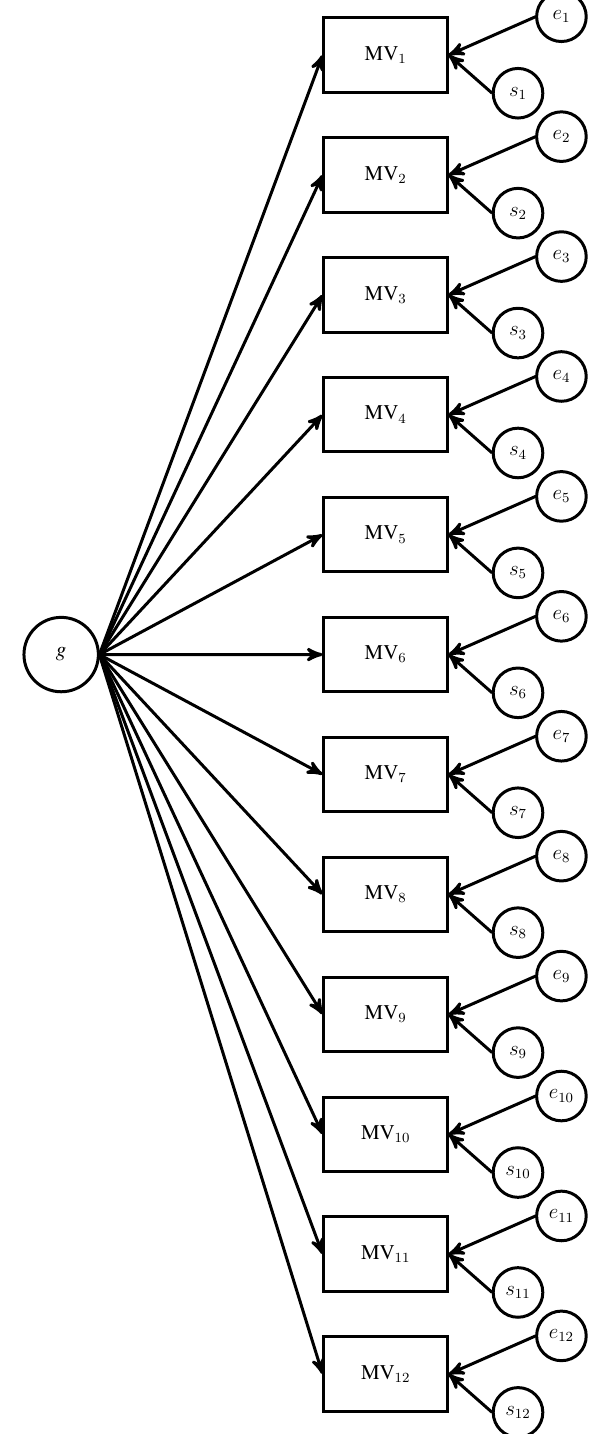
Figure 1. Example of a two-factor model. MV: measured variable; s : specific factors; e :